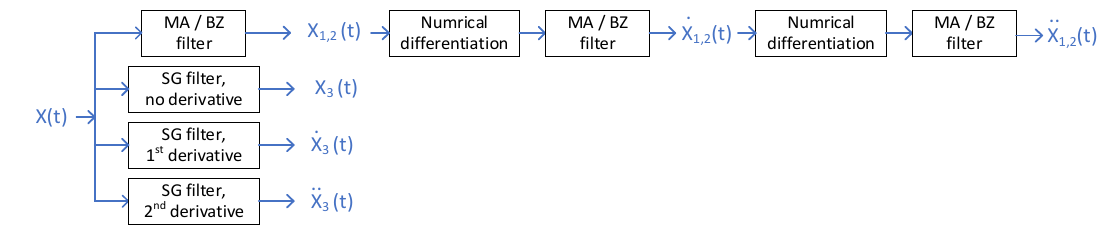
Figure 2. Signal processing to obtain first and second derivative.